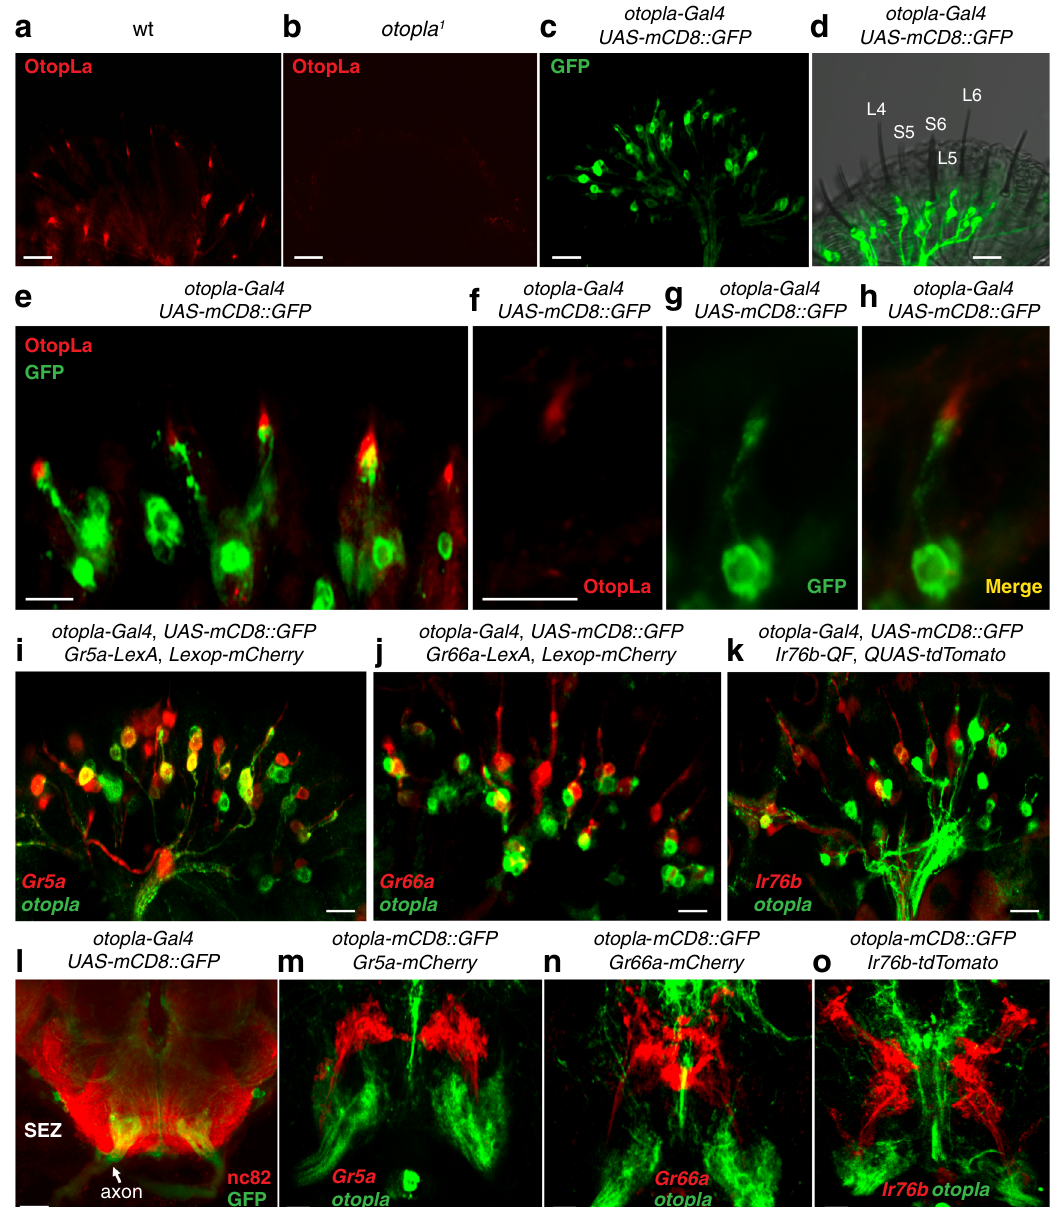
Fig. 5 Expression patterns of otopla in the fl y taste system. a , b Immunoreactivity of anti-OtopLa in wild-type (wt; a ) and otopla 1 ( b ) proboscises. c Expression of otopla-Gal4 in the labellum. d Distribution of L- and S-type taste sensilla relative to the dendrites of otopla- expressing GRNs in the proboscis. e Double labeling of anti-OtopLa and anti-GFP in otopla-Gal4 ; UAS-mCD8::GFP fl ies. f – h Localization pattern of OtopLa in a single GRN dendrite. i – k Localization of otopla -positive sour GRNs relative to Gr5a -positive sweet GRNs ( i ), Gr66a -positive bitter GRNs ( j ), and Ir76b -positive salty GRNs ( k ). l Projection pattern of otopla -positive GRNs in the subesophageal zone (SEZ). Arrow indicates otopla -positive GRN axon bundles. m – o SEZ projections of otopla -positive GRNs relative to Gr5a -positive GRNs ( m ), Gr66a -positive GRNs ( n ), and Ir76b -positive GRNs ( o ). All immunocytochemical experiments were repeated at least three times with similar results. Scale bars: 20 µ m ( a – d , m – o ), 10 µ m ( e – k ), 50 µ m ( l